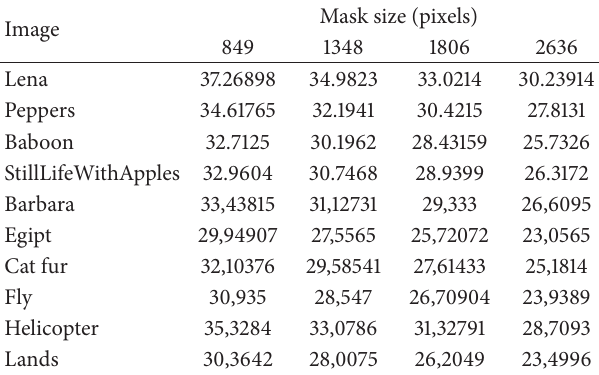
Table 2: The initial PSNR values depending on the mask